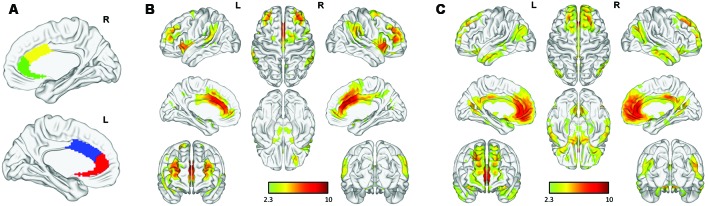
Functional connectivity of anterior cingulate cortex (ACC) subregions: (A) rostral (green, red) and caudal (yellow, blue) ACC in each hemisphere. Distinct functional connectivity was observed in the bilateral (B) caudal ACC (cACC) and (C) rostral ACC (rACC).